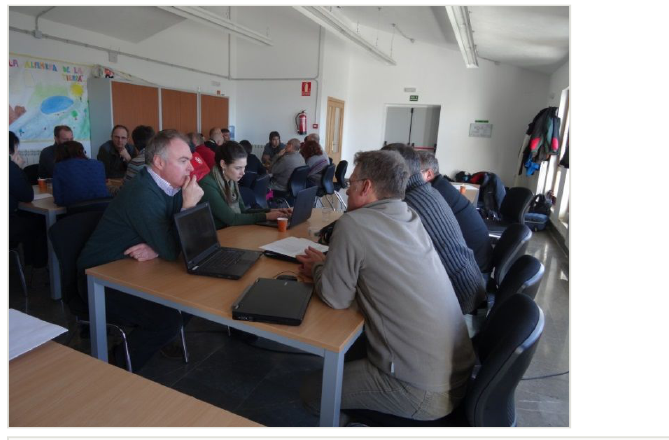
Participants of the 3rd EU BON Stakeholder Roundtable discussing details of the work fl ow (credits: Katrin